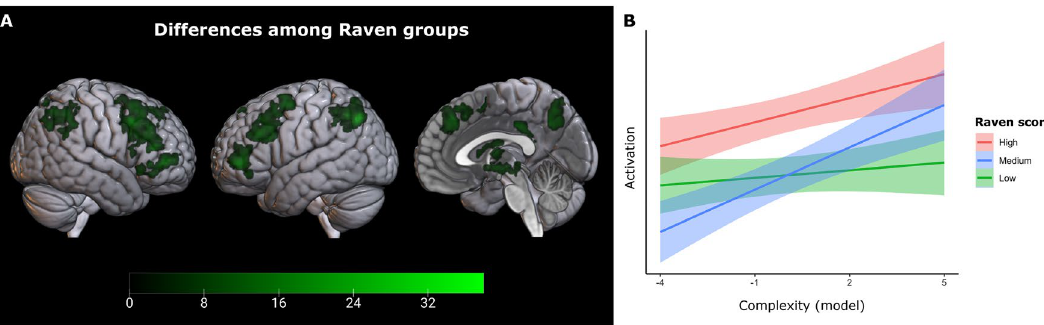
Figure 6. Brain response to strategic complexity in different Raven subgroups. Brain regions showing a different relation with strategic complexity in the three Raven subgroups ( A ). Relation between complexity and activation in the three Raven subgroups with high, medium, or low Raven scores ( B ). In ( B ), we averaged the signal in all regions reported in ( A ), that is, those regions showing a subgroup effect. The areas in ( A ) are color- coded according to the color scale below the maps showing the corresponding F -values. Areas on the map are thresholded at 0.001 at the voxel level and at 0.05 at the cluster level, FWE-corrected for multiple